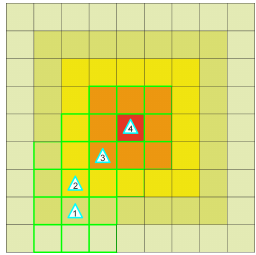
Figure 2. Hillclimbing for finding local